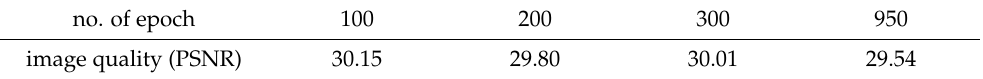
Table 6. Performance comparison by training amount of the recursive learning stage.